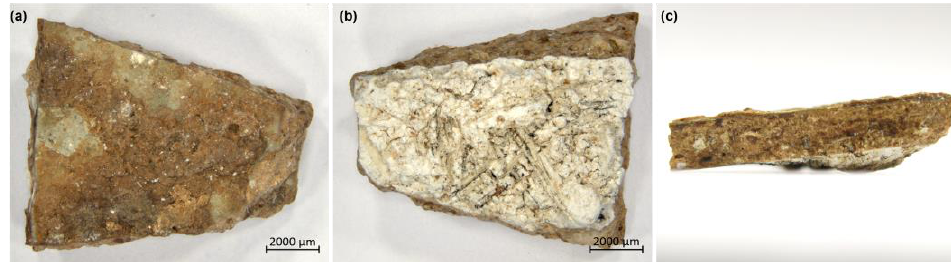
Figure 2. Status of mural sample ( a ) Front, ( b ) Back, ( c ) Side.